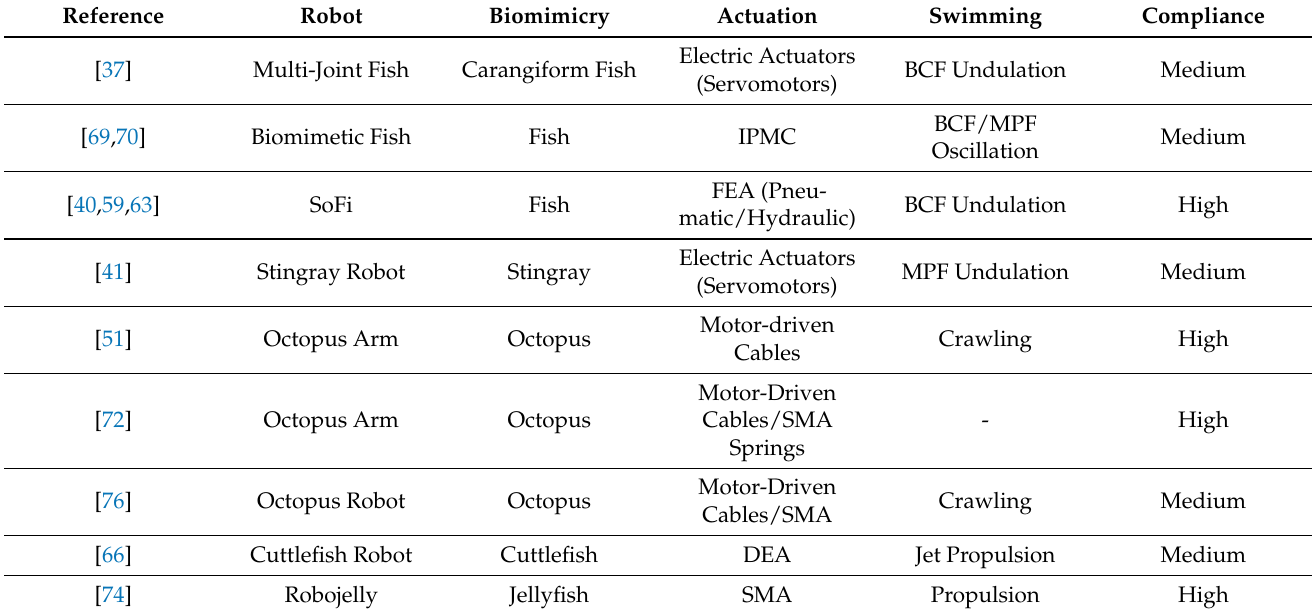
Table 1. Classification of various underwater soft robotic